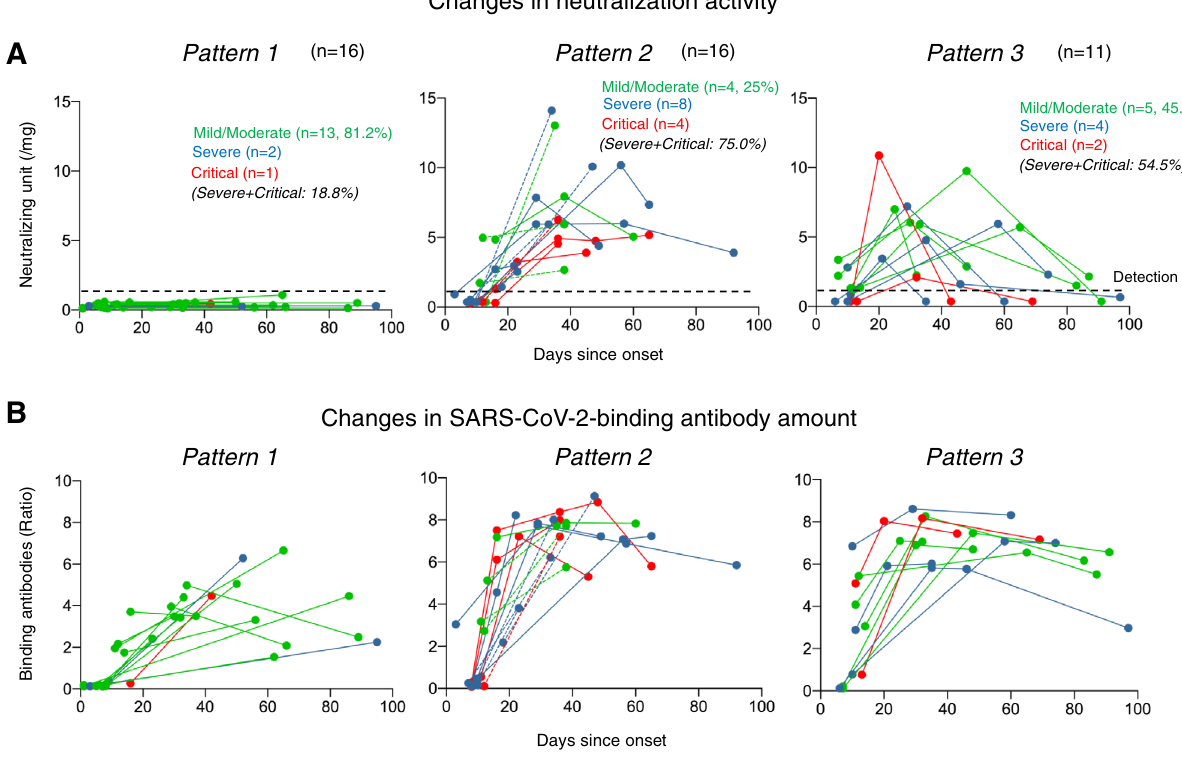
Figure 3. Changes in neutralizing activity and SARS-CoV-2-S1-binding antibody levels. ( A ) Neutralizing activity of each IgG fraction and the amount of SARS-CoV-2-binding antibody in serum/plasma obtained from multiple time points in the 43 patients were determined. The neutralizing activity of each IgG fraction was normalized and presented as a neutralizing unit, as described in the legend to Fig. 2. The definition of Patterns [Pattern 1, in which no neutralizing activity was observed during observation periods; Pattern 2, in which the neutralizing activity was maintained during observation periods, or cases with two time-point data only (shown with dashed line); Pattern 3, in which neutralizing activity was lost after the peak of the activity by < 40% during observation periods]. For the neutralizing activity in Pattern 3 (upper right panel), the average time period from the disease onset to reach the peak of activity was 36 days, and the average time period it took for the same individual to lose the activity by 50% or more from the peak was 24 days. The dashed line in the three upper panels denotes the detection limit value (1 neutralization unit). ( B ) Changes in SARS-CoV-2-S1-binding antibody amounts in patients in each Pattern group. For the definition of severities of patients, see the footnote to Table